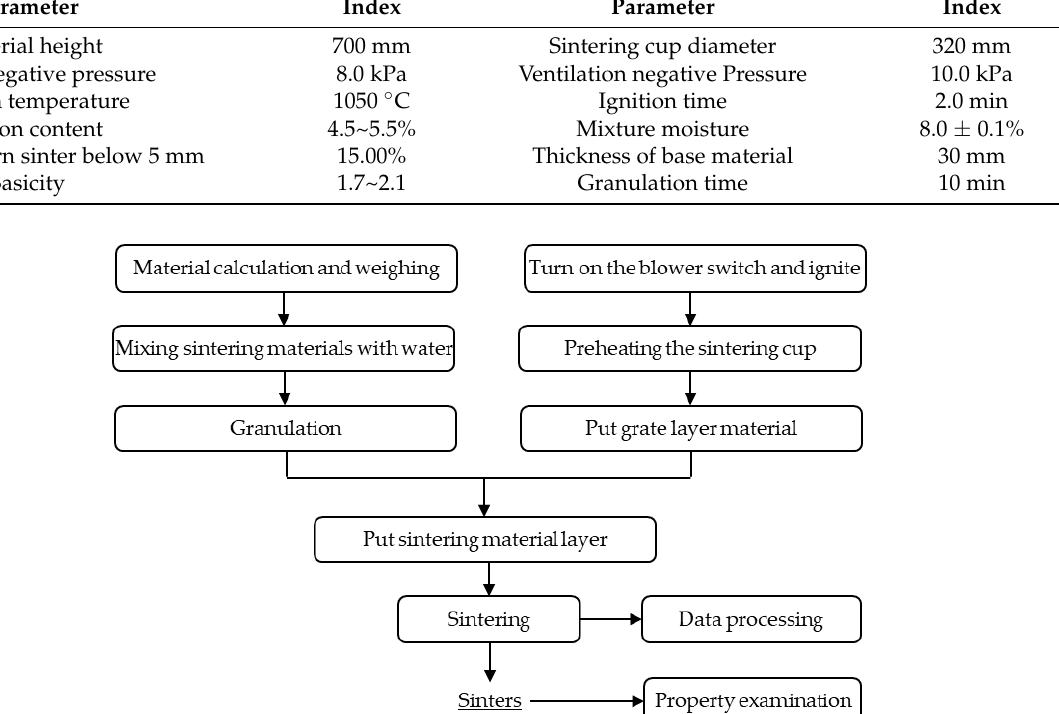
Table 2. Cold preparation, prepelletization stage and sintering parameters.